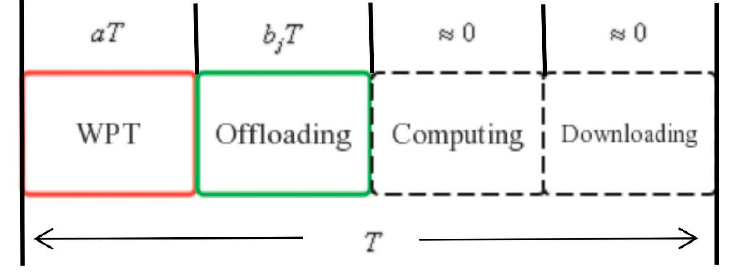
Figure 2. System time allocation.